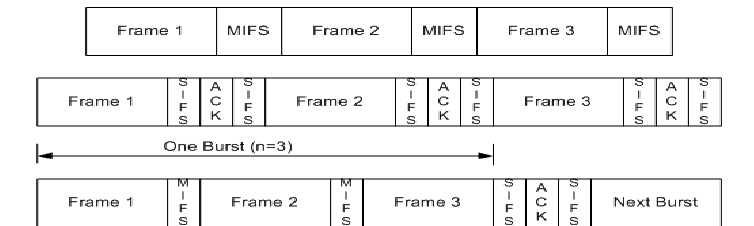
Figure 3. No-ACK, Imm-ACK and Dly-ACK (Burst Size = 3) : Different ACK Policies in IEEE